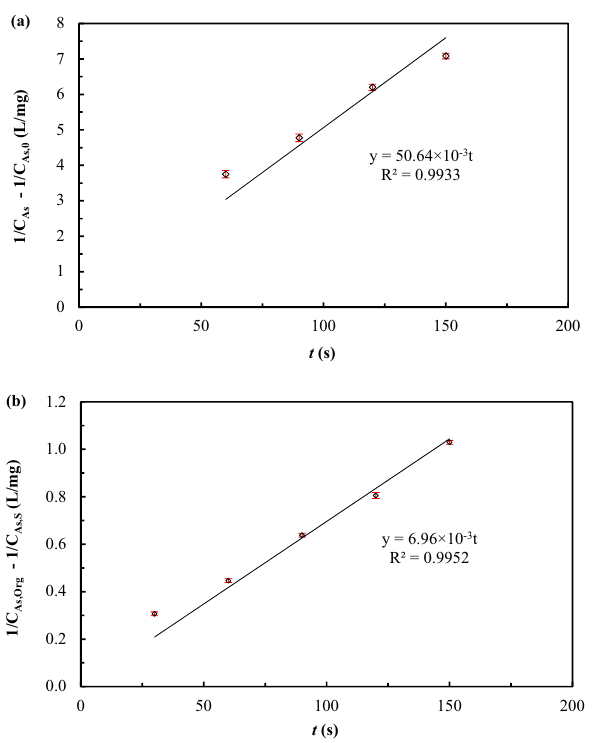
Figure 7. Graphs plotted between the integral concentration of arsenic ions versus time: ( a ) extraction reaction; standard deviations = ± 0.09. ( b ) Stripping reaction standard deviations = ±